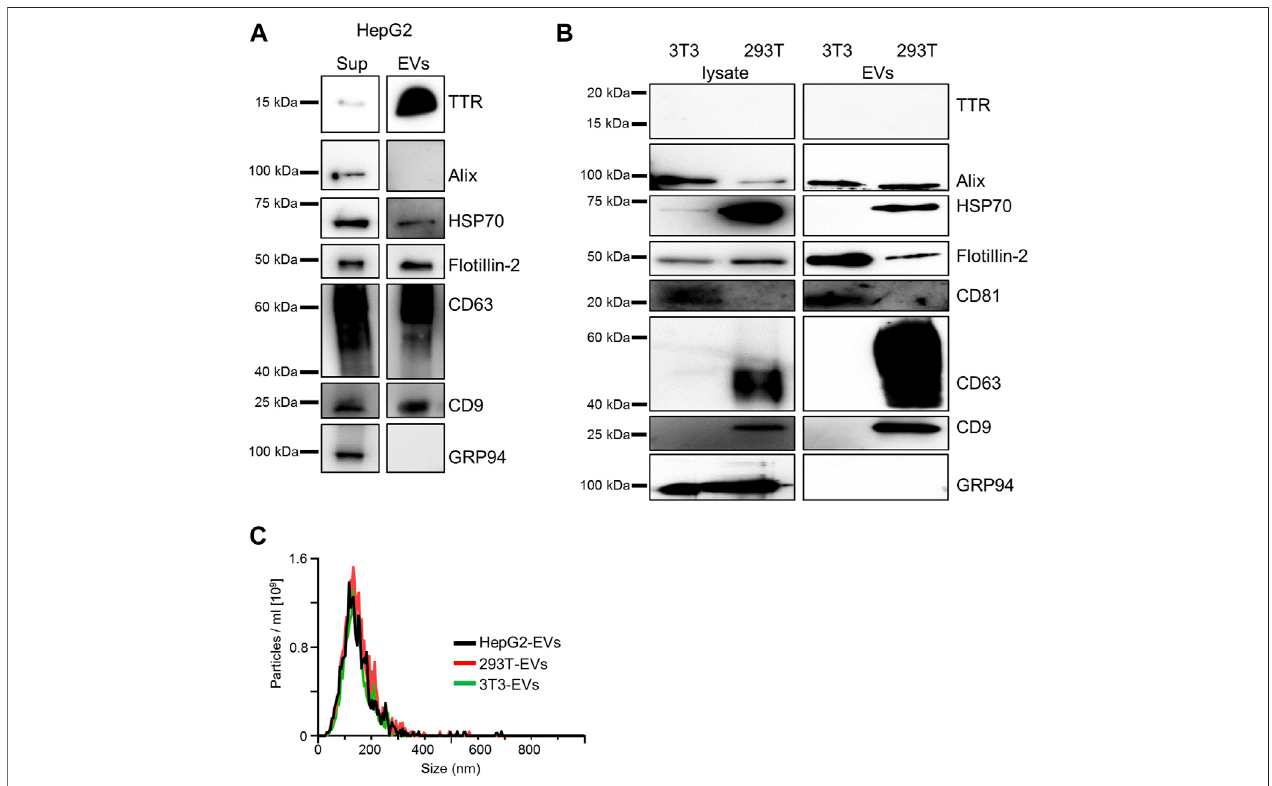
FIGURE 1 | HepG2-derived EVs contain TTR whereas HEK293T-derived EVs or NIH3T3-derived EVs do not. (A) TTR monomer was detected in western blotting analysisoftheculture supernatant ofHepG2 and HepG2-derived EVs. (B) TTRwasnotdetected inwesternblottinganalysisofthecell lysate andcell line-derived EVs in HEK293T and NIH3T3. 3T3 (NIH3T3), 293T (HEK293T). (C) Analysis of three cell line-derived EVs [HepG2 (black), HEK293T (red), and NIH3T3 (green)] by NanoSight (Raw mode). The diameter and distribution of cell line-derived EVs were similar among the cell lines. All EVs were 40 ng/ml before measurement and were diluted 30-fold with PBS immediately before analysis. Particle concentrations were as follows: HepG2 cell-derived (2.52 × 10 10 ± 1.19 × 10 9 ), HEK293T-derived (2.96 × 10 10 ± 1.01 × 10 9 ), and NIH3T3-derived EVs (2.23× 10 10 ± 1.28 × 10 9